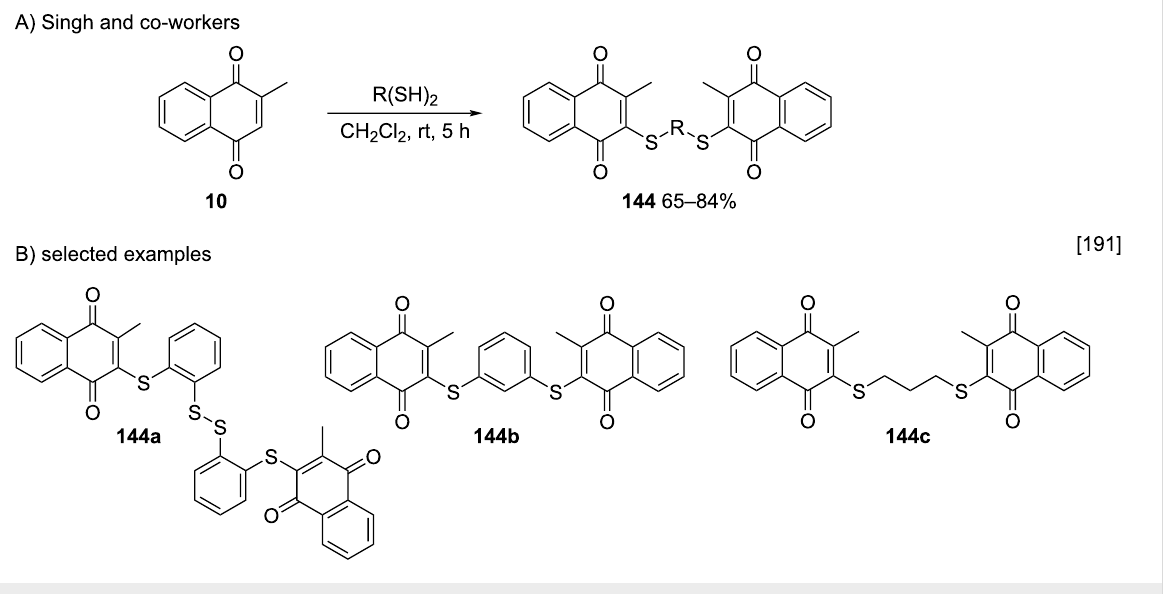
Scheme 52: Synthesis of menadione-derived symmetrical derivatives through reaction with dithiols.